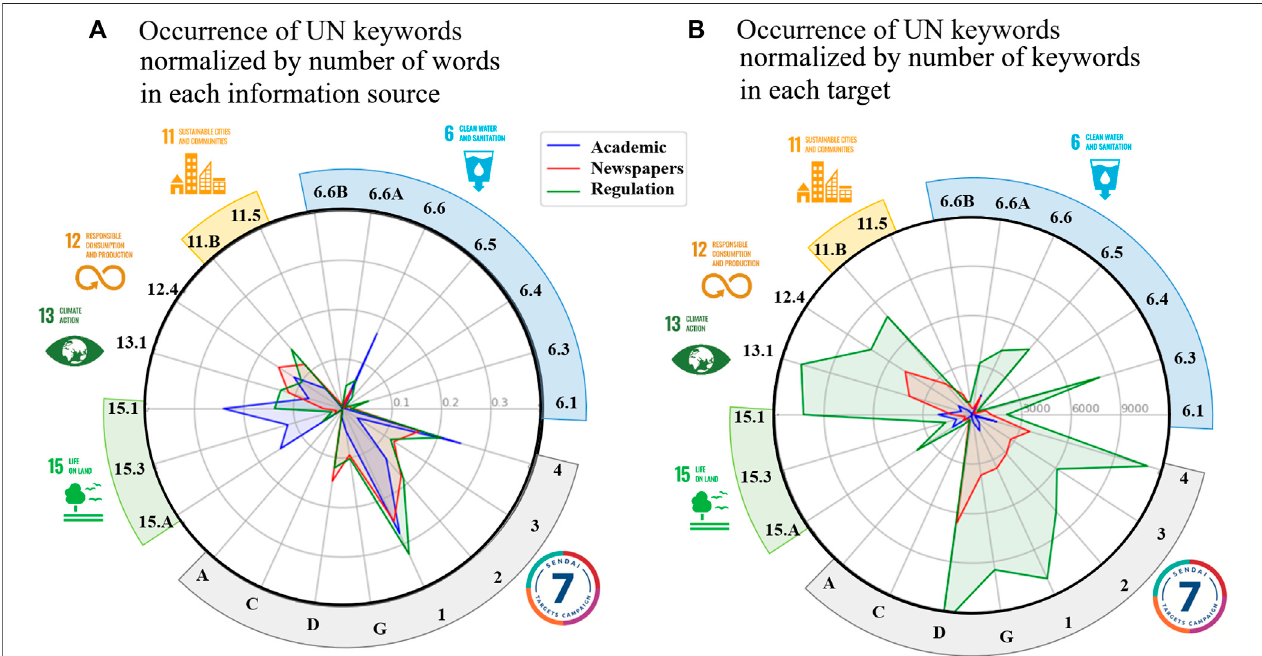
FIGURE 4 | Polar chart showing occurrences of the UN keywords in the three information sources, including only the occurrences of keywords selected by all fi ve authors. Occurrences are shown for the academic (blue), newspaper (red) and local regulatory (green) sources. (A) Total UN keyword occurrences of UN objectives normalized by the total number of words in each information source (academia, newspapers and regulation, being approximately 86.000, 314.000 and 743.000, respectively). The data is the same for the three word occurrence distributions because occurrences have been normalized by the total number of words in each information source. (B) Total UN keyword occurrences of UN objectives normalized by the number of UN keywords identi fi ed in each UN